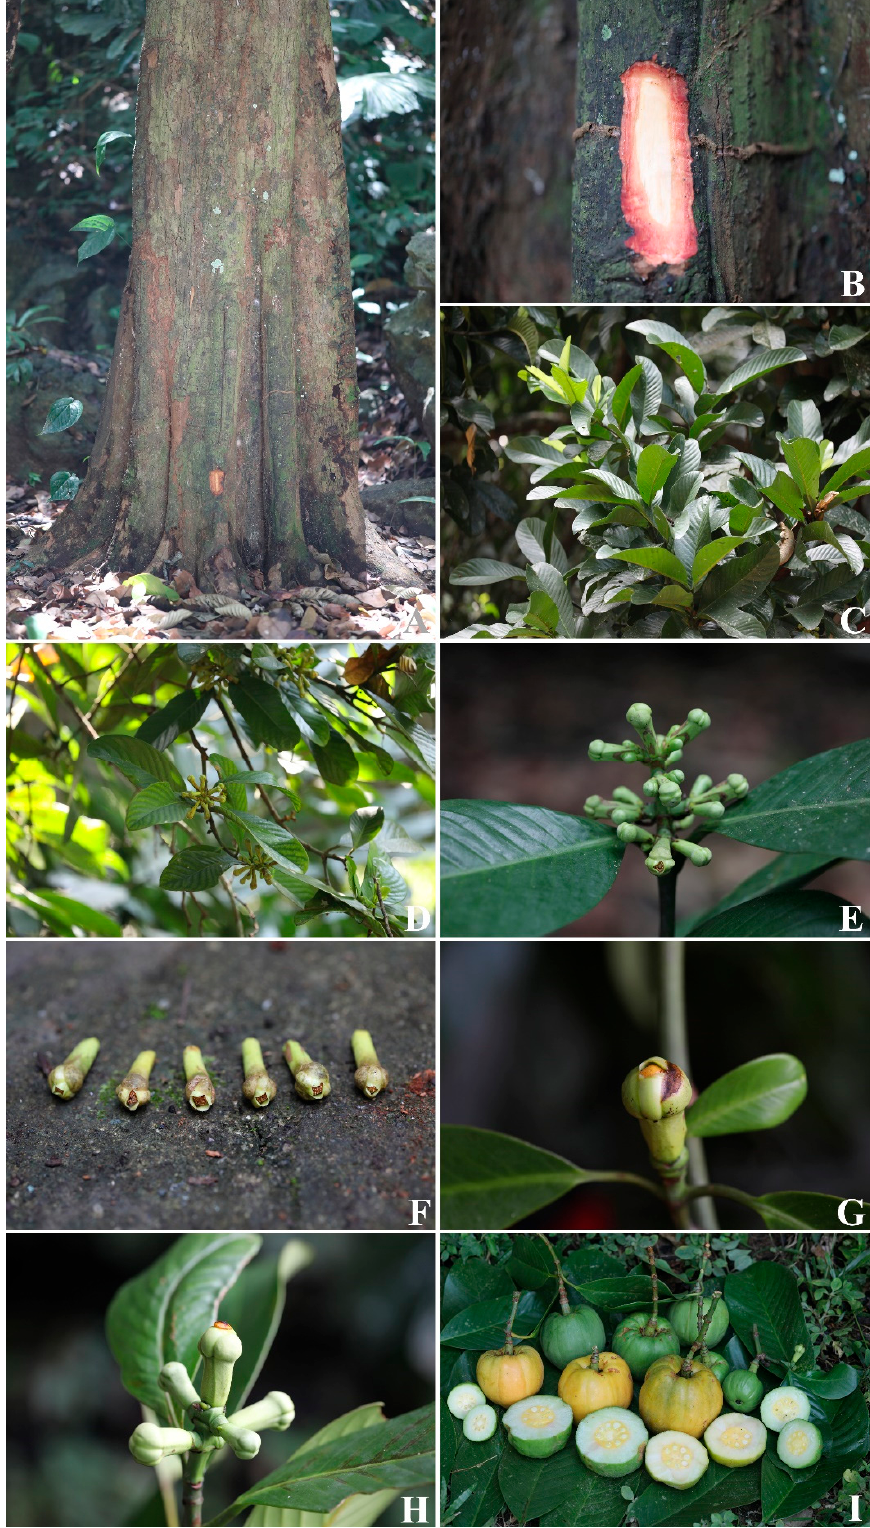
Figure 11. Garcinia pedunculata : ( A ) stem, narrowly buttressed and outer bark; ( B ) outer bark and inner bark with colourless latex; ( C ) branches, young and mature leaves; ( D ) male flowering branches; ( E ) inflorescence with male flowers; ( F ) fallen male flowers; ( G ) female flower; ( H ) inflorescence with female flowers; ( I ) mature and ripe fruits, showing pericarps and seeds (cross section). Photos: Chatchai Ngernsaengsaruay.